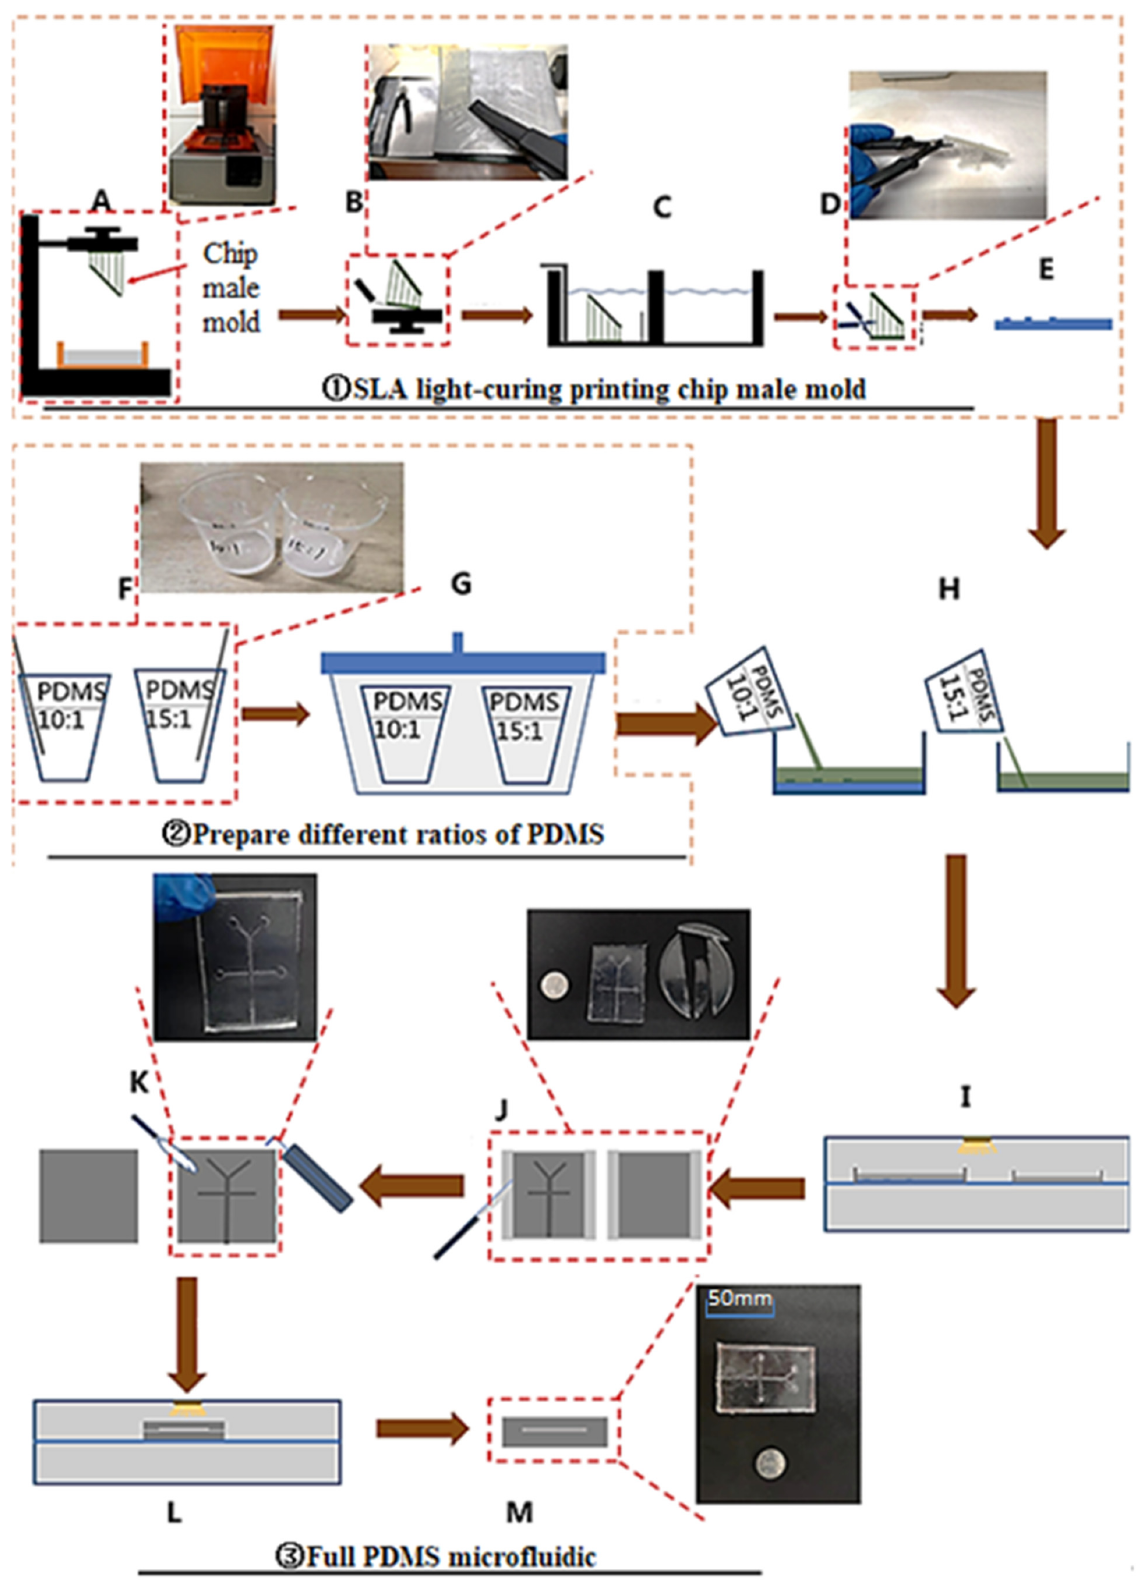
Figure 1. Schematic diagram of the preparation process of the micro-droplet chip. ( A – E ) Printing process of the chip convex mold; ( F – G ) The PDMS preparation process of different proportion; (H-M) Full PDMS microfluidic chip molding process.